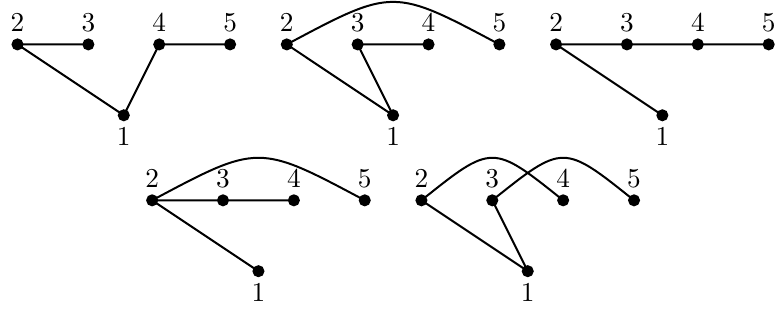
Figure 3 . The 5-point spanning trees that contribute to n NLSM (1 , { 2345 } , 6).